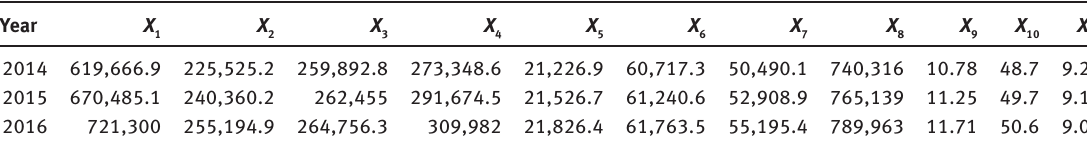
Table 3: Influencing Factors of Railway Freight Volume in 2014–2016.